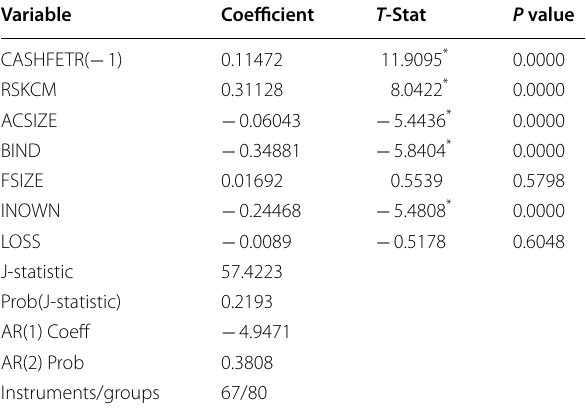
Table 8 Additional test (GMM). Source Researcher’s compilation